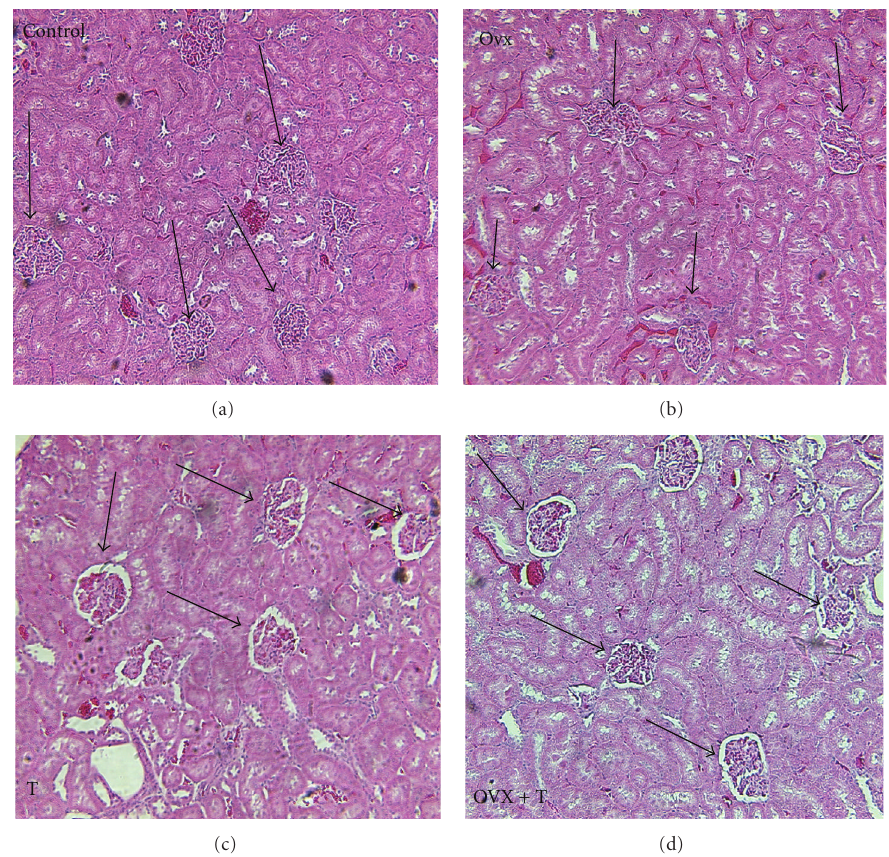
Figure 4: Representative renal micrographs stained with hematoxylin and eosin by treatment groups (controls, OVX: ovarectomy, T: testo- sterone, OVX+T: ovarectomy and testosterone) showing glomerulosclerosis (arrows point to glomeruli, magnification = 100x).